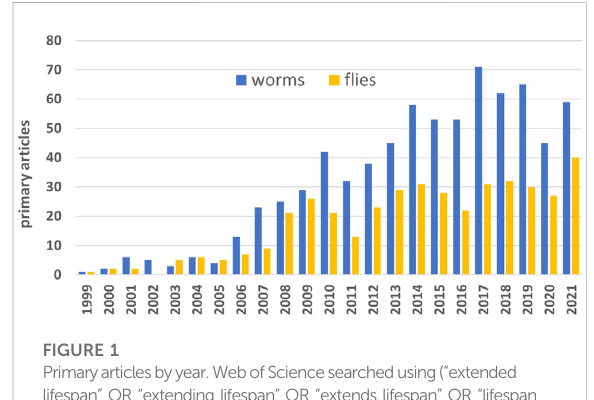
FIGURE 1 Primaryarticlesbyyear.WebofSciencesearchedusing( “ extended lifespan ” OR “ extending lifespan ” OR “ extends lifespan ” OR “ lifespan extension ” ) AND either Drosophila or elegans in Research